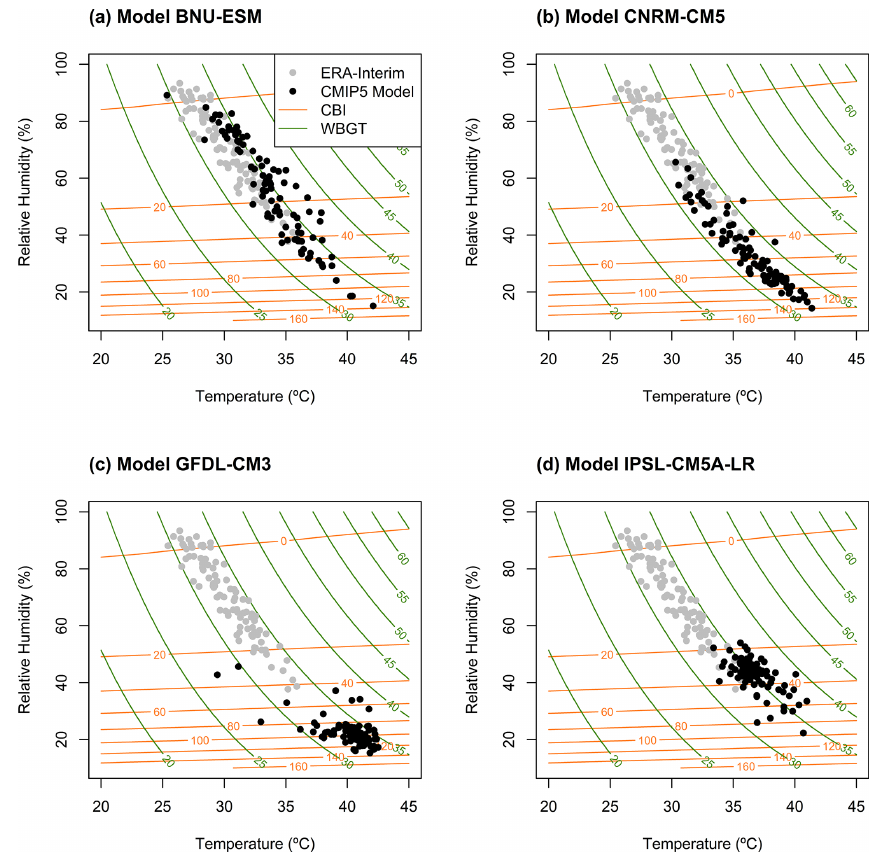
Figure A1. Samples of hourly 2m air T ( ◦ C) vs. RH (%) during the period 1979–2005 for ERA-Interim reanalysis (grey points) and four models (black points) from the CMIP5 multimodel ensemble (BNU-ESM (a) , GFDL-CM3 CNRM-CM5 (b) , GFDL-CM3 (c) , and IPSL- CM5A-LR (d) ) for a grid point in Brazil (Amazonia, 5 ◦ S and 56.5 ◦ W) indicated throughout map plots in the Results section (Sect. 4) with X markers. The isolines illustrate equal levels of the hazard indices of fire (orange) and heat stress (green), corresponding to CBI and WBGT indices, respectively, which are both functions of T and